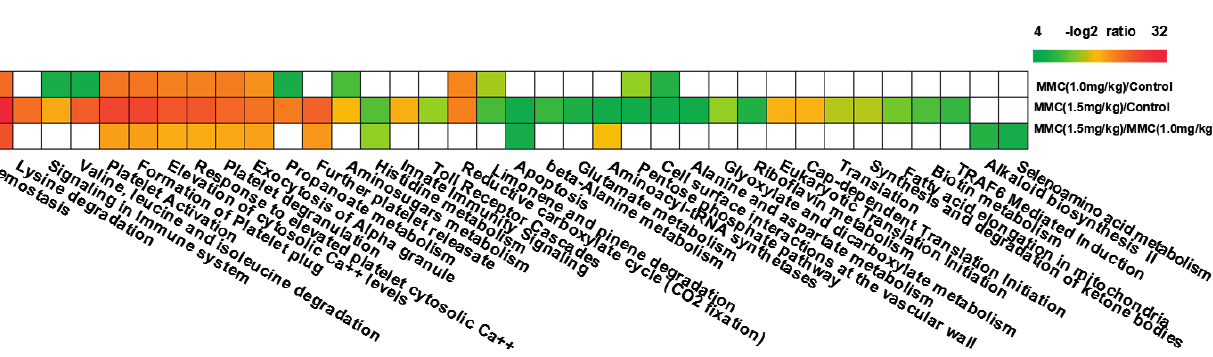
Figure 3. Significant pathways at the nominal level of 0.05 during the unpaired Student’s t -test. The DE genes in tumors treated with curcumin/MMC at the dose of 1.5 mg/kg and curcumin/MMC at the dose of 1.0 mg/kg were mapped to the IPA-defined work. The significance p values that determine the probability associated with the genes in the